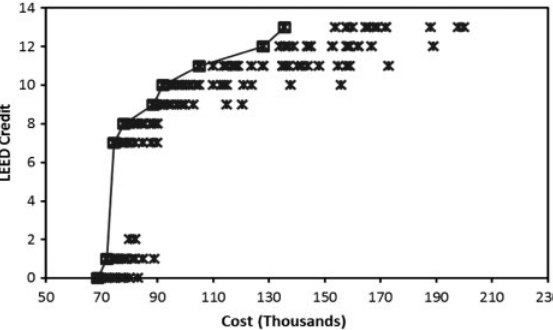
Fig. 5. Pareto front of ACMO